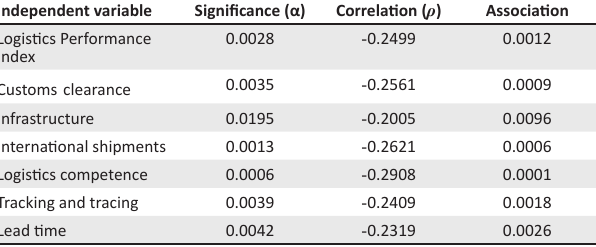
TABLE 3: Relationships between dependent and independent variables.